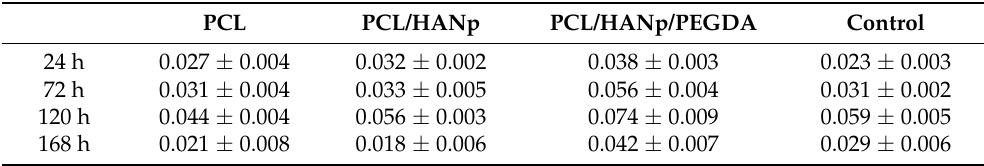
Table 4. Corrected absorbance evaluated by PrestoBlue ® viability assay for hDPSCs after 24, 72, 120 and 168 h. Results presented in mean ± SE.